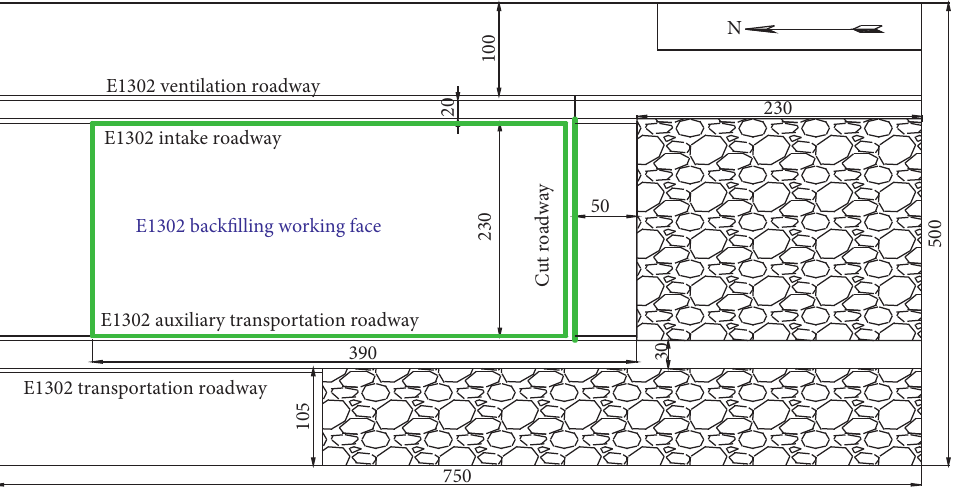
Figure 1: E1302 working face mining plane schematic. Table 1: Coal (rock) mechanical parameters.